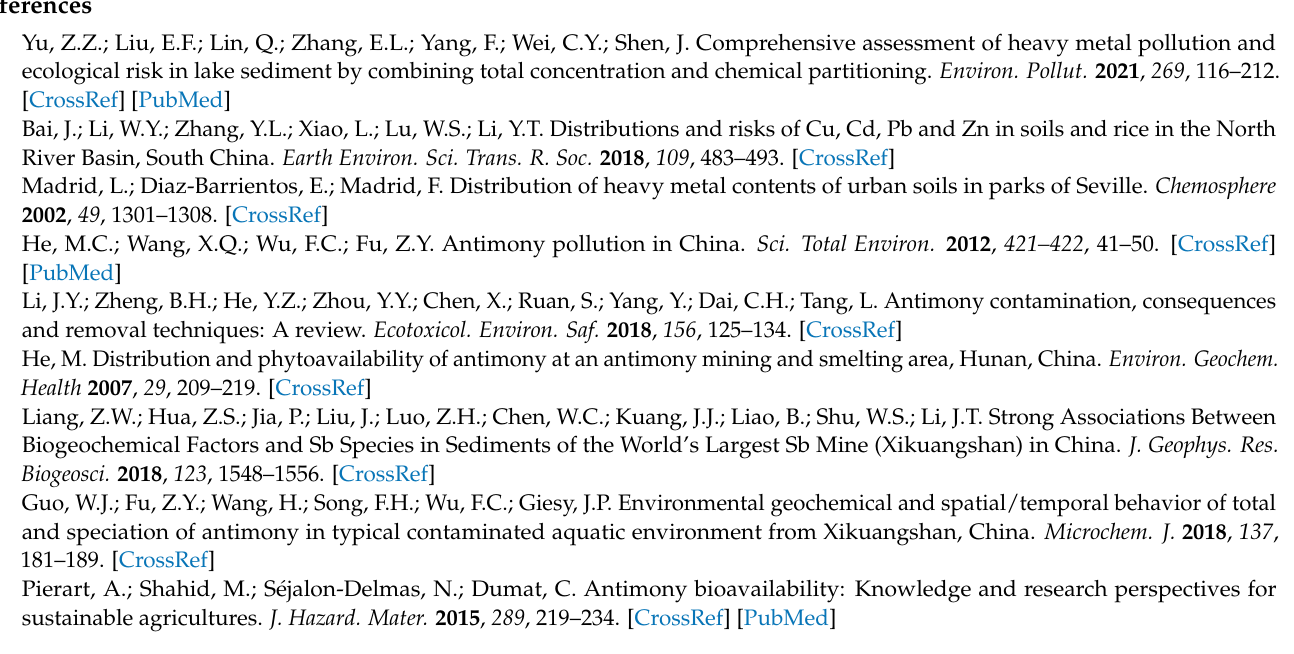
risk, Table S4: Values of variables for human health risk assessment models, Table S5: Summary of reference dose (RfD) and cancer slope factor (SF) values for each element from different exposure pathways, Table S6: Correlation coefficients between the PTEs concentrations in the study area, Table S7: Average daily intake (ADI) values for adults and children in soil from XKS mining area for non-carcinogenic risk calculations, Table S8: ADI values for adults and children in soil from XKS mining area for carcinogenic risk